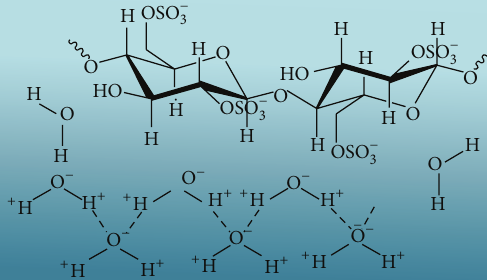
Figure 10: Formation of sulfate group on the nanocellulose surface after hydrolysis